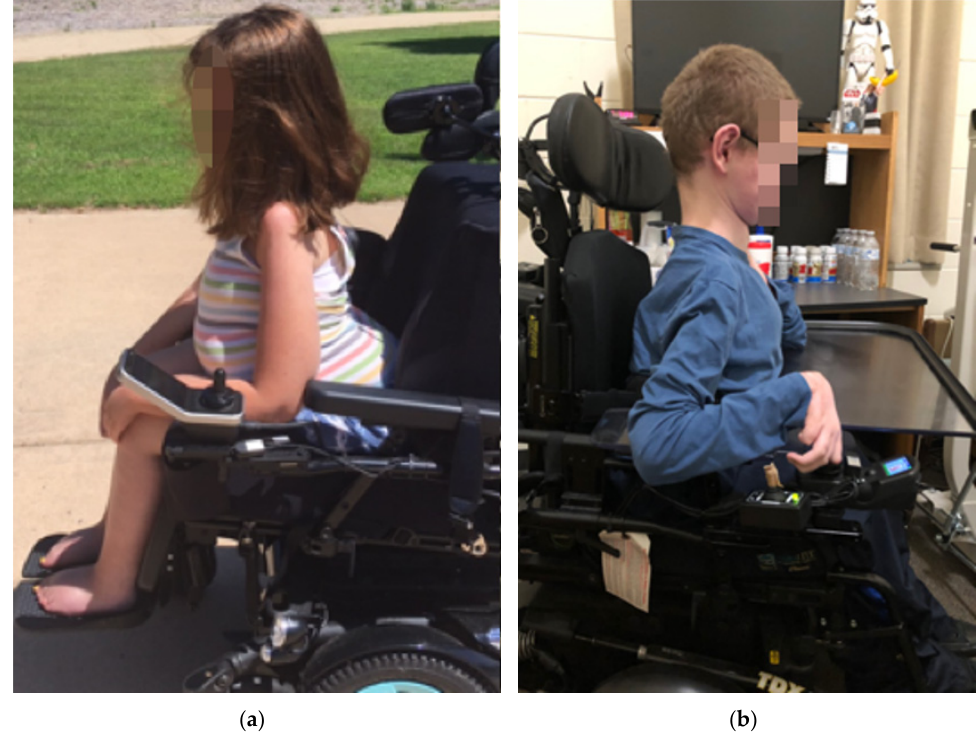
Figure 1. Clinical photos of “trunk tip” ( a ) and “tucked chin” ( b ) deformities. With the “trunk tip” deformity, note the space between the back of the chair and the posterior chest wall.